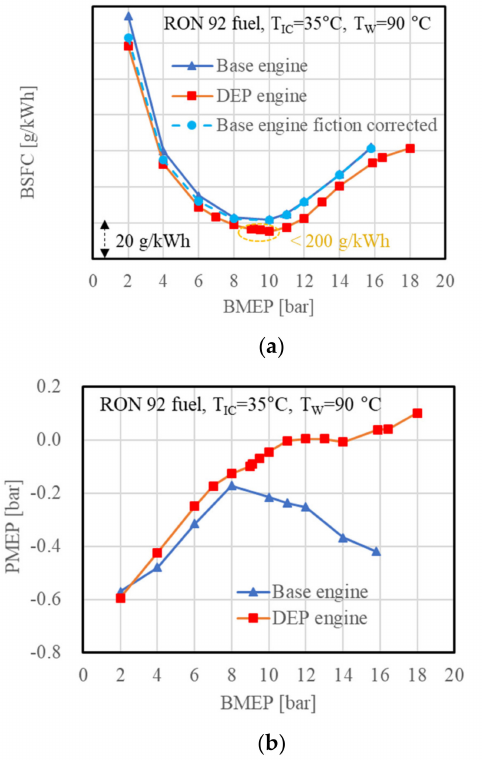
Figure 12. Part load characteristics comparison ( a ) BSFC ( b ) PMEP.